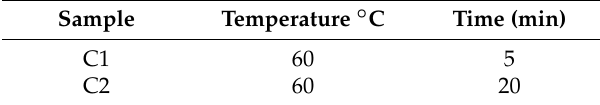
Table 2. Reactions conditions used in method C (power 900 W and frequency 2455 MHz).